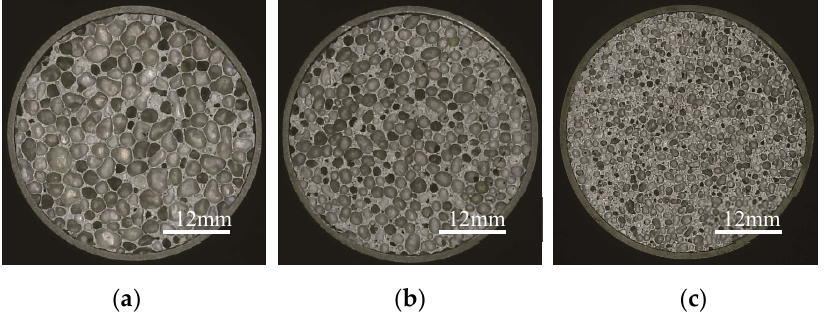
Figure 2. Al tubes filled with different cell sizes of aluminum foams Test No. 1 ( a ), Test No. 5 ( b ), and Test No. 12 ( c ).